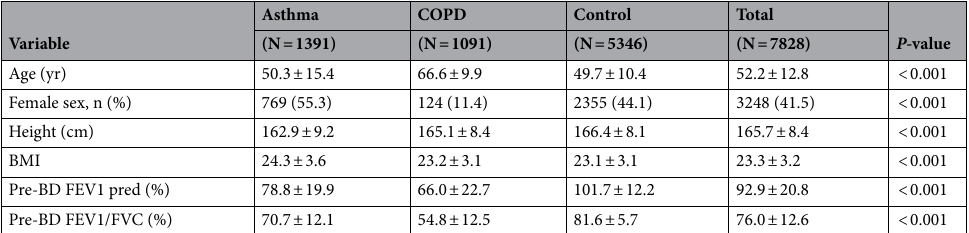
and regional plots indicate a genome-wide significant region. rs2961757 is located near NMUR2 on chromo- some 5. In addition, in the first plot of Fig. S3, the genotyped SNP is indicated by a red dot in the Manhattan plot. The regional plot was produced using only genotyped SNP. The Miami plot of the results is presented in Fig. S4. Table 2 lists the top ten most significant SNPs. Minor allele frequencies in the disease group are shown in Table S1. If several genome-wide significant SNPs were present in the same linkage disequilibrium (LD)